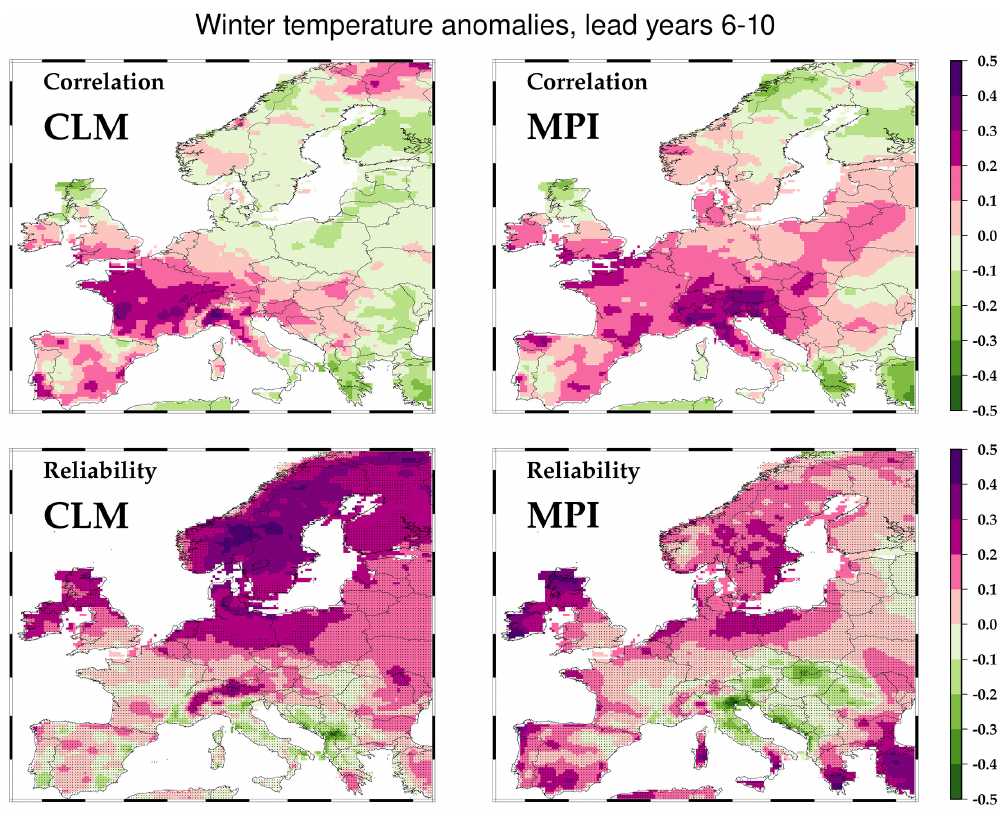
Figure 14. Winter half-year temperature anomaly means for lead years 6–10 from 1961 to 2010. The top panels show the correlation coefficient between E-OBS observations and CCLM (left) and MPI-ESM-LR (right). The bottom panels show the reliability of the CCLM (left) and MPI-ESM-LR (right) ensembles with respect to the E-OBS observations. Stippling indicates results, significant at the 10%